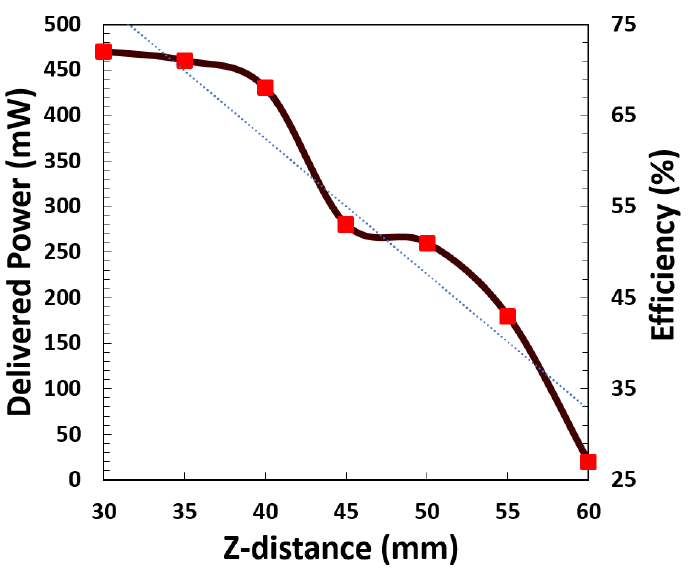
Figure 9. Variation of delivered power to internal coil and system efficiency vs. height changes of internal coil (X position is fixed to 25 mm for all